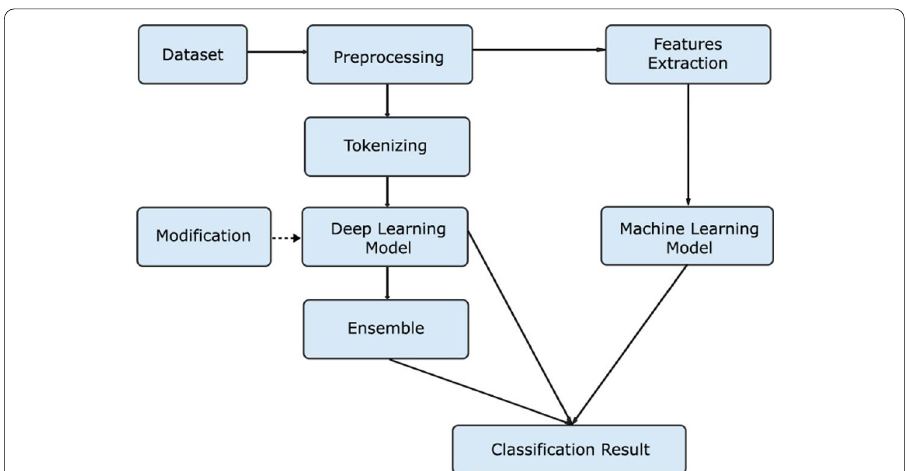
Fig. 2 General experiment